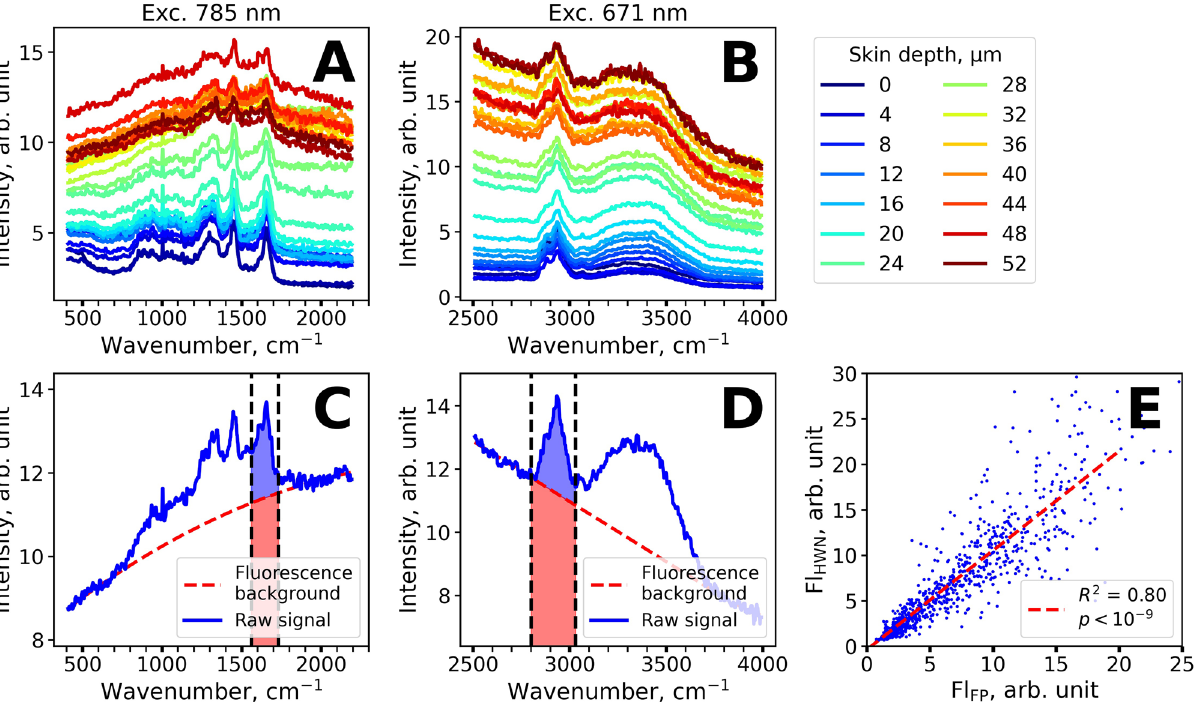
Figure 1. Characteristic depth-resolved Raman spectra of skin in vivo and examples of fluorescence background subtraction. ( A , B ) Depth-resolved Raman spectra of the human skin in the 400–2,200 cm −1 ( A ) and 2,500–4,000 cm −1 ( B ) ranges. Spectra are color-coded according to the measurement depth, ranging from 0 to 60 µm with 2 µm increments. ( C , D ). The examples of fluorescence background subtraction (red dashed line) for representative Raman spectra (blue line) in the 400–2,200 cm −1 ( C ) and 2,500–4,000 cm −1 ( D ) ranges. Red and blue areas filled in ( C , D ) represent fluorescence and Raman signal intensities used to estimate normalized fluorescence intensity (Fl-FP and Fl-HWN). ( E ) Correlation between the normalized fluorescence Fl-FP and Fl-HWN excited at 785 and 671 nm,